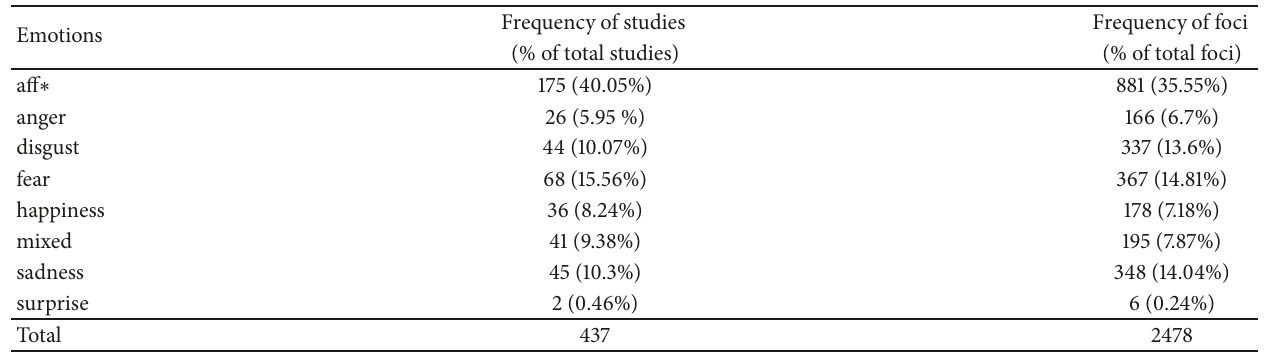
Table 5: Frequency of